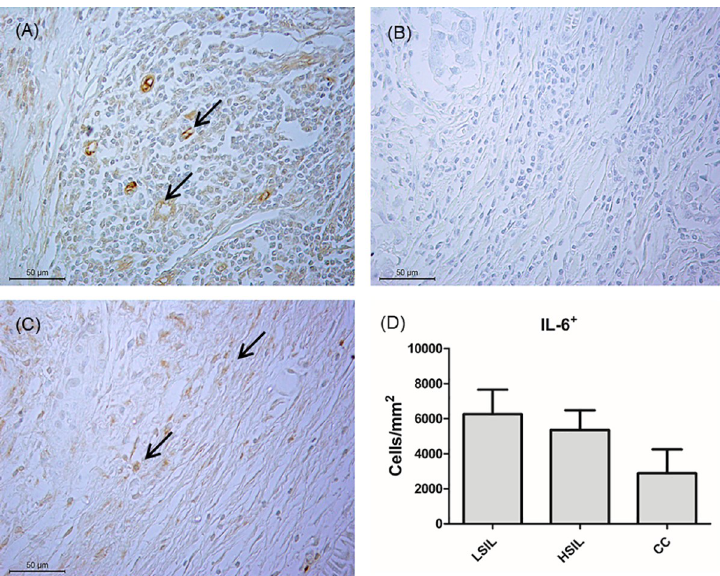
Fig 1. Cells expressing IL-6. (A) Human tonsil sections labeled with primary anti-human IL-6 antibody. (B) Human tonsil sections without primary anti-human IL-6 antibody. (C) Uterine cervix biopsies labeled with primary anti- human IL-6 antibody. The black arrow corresponds to IL-6 + cells. All figures are presented in the same magnification (400 × ). (D) The number of cells expressing IL-6 in samples of uterine-cervix biopsies with histopathological lesions.